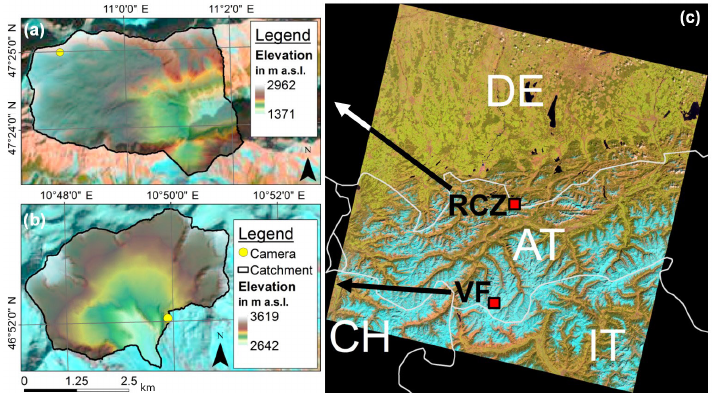
Figure 1. The figure shows the two test sites used in this study and their location within a Landsat scene, with the camera location in yellow, the catchment area outlined in black and the digital elevation model (DEM) superimposed on a LandsatLook image. (a) Research Catchment Zugspitzplatt (Germany), (b) Vernagtferner catchment (Austria), (c) Landsat scene (LandsatLook image, WRS2 path 193, row 27) which contains both